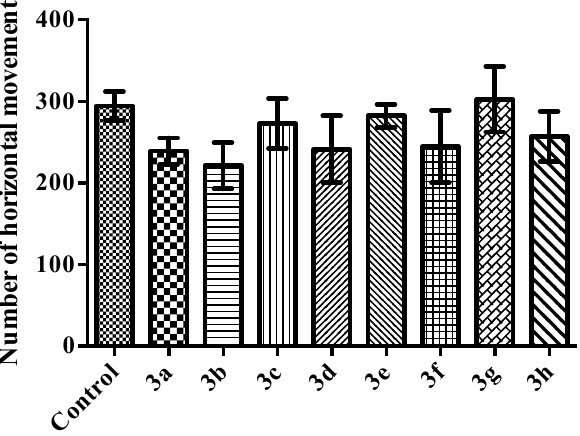
Figure 5. The effects of the test compounds 3a – 3h (40 mg/kg) on the horizontal locomotor activities of the mice in activity cage test. Values are given as mean ± SEM, ( n = 6).